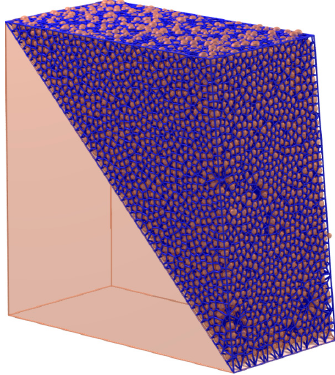
Figure 14. The solid cell system in State 1.